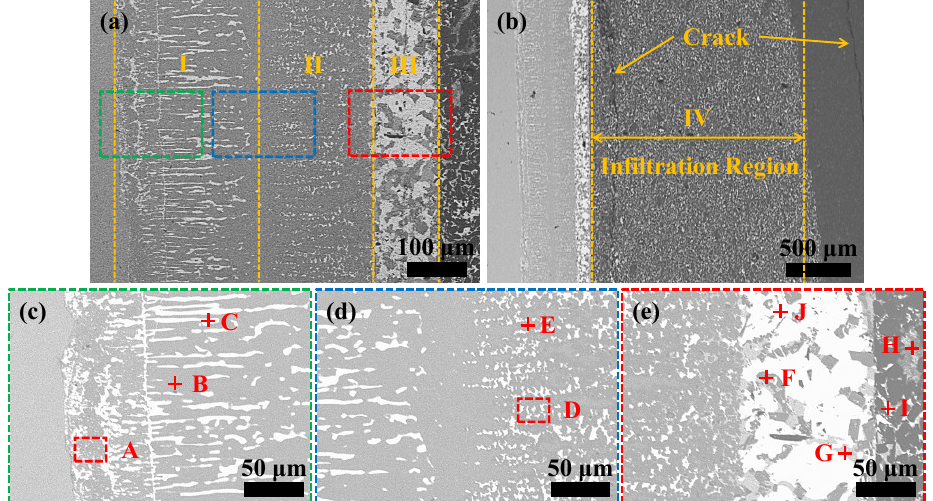
Figure 2. The typical microstructure of PS-SiC-stainless steel joint: ( a ) the microstructure of brazing seam; ( b ) complete microstructure of joint; and magnification drawing of ( c ) Region I; ( d ) Region II; and ( e ) Region